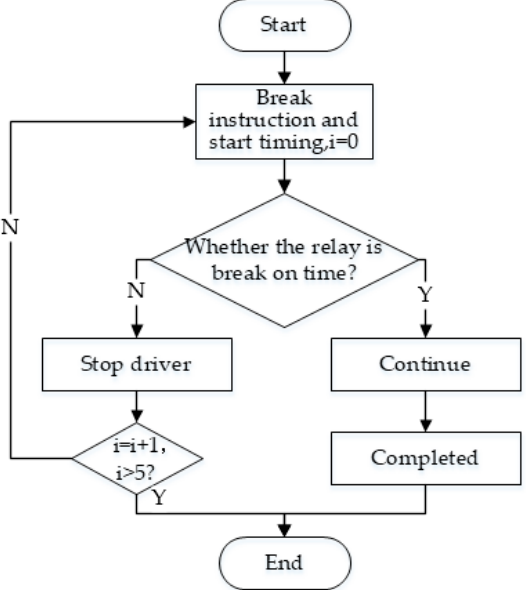
Figure 8. Flow chart of phase-locked function.